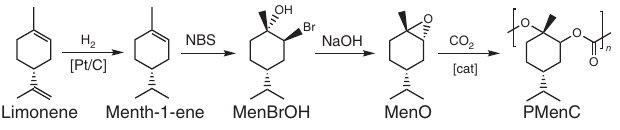
Figure 6 | The saturation of PLimC. The synthetic route to PMenC starts from the metal-catalysed hydrogenation of limonene, followed by the stereoselective epoxidation of Men via its bromohydrin (MenBrOH) to trans -MenO and the subsequent copolymerization with CO 2 to give the saturated PC